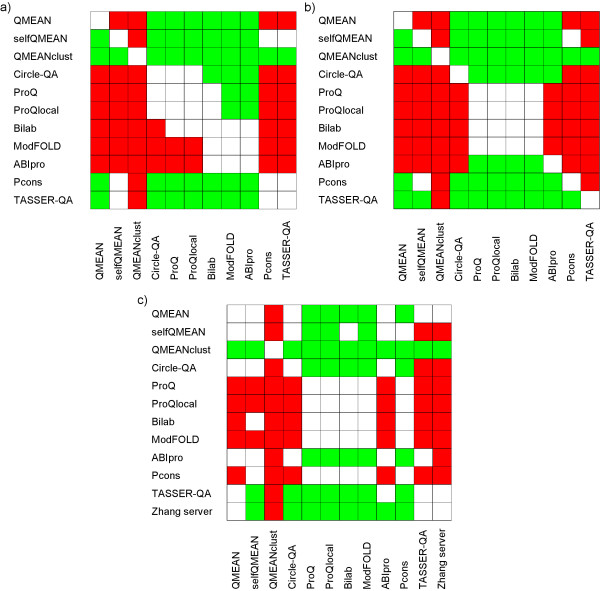
Analysis of the statistical significance based on a one-sided paired t-test (95% confidence level). Green: Method denoted on the horizontal performs significantly better. Red: Method denoted on the horizontal performs significantly worse. a) Pearson's correlation coefficient, b) Spearman's rank correlation coefficient, c) GDT_TS values of the models selected model by a scoring function.